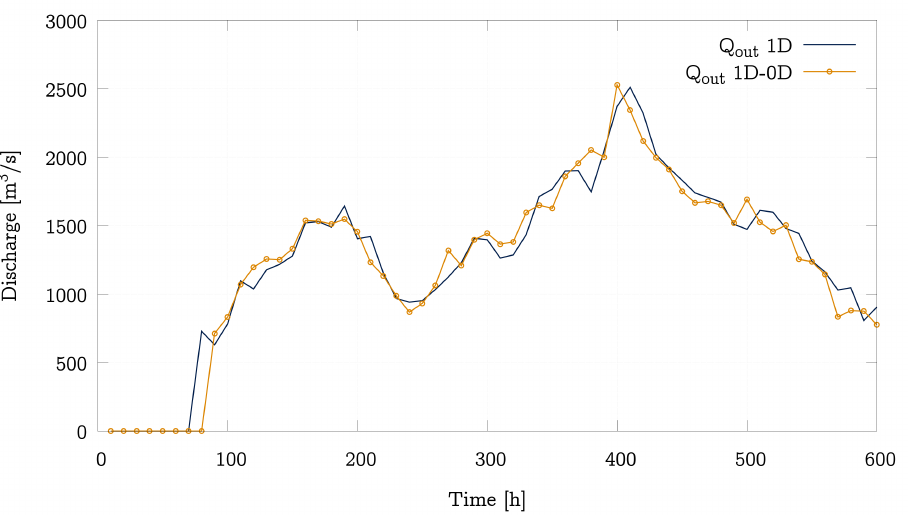
Figure 15. Temporal evolution of the outlet discharge at Mequinenza dam (E003) computed with the 1D model and the coupled 1D-0D model for the 2015 case with the control of a PID algorithm. The computational times for the model with the PID algorithm are shown in Table 3.